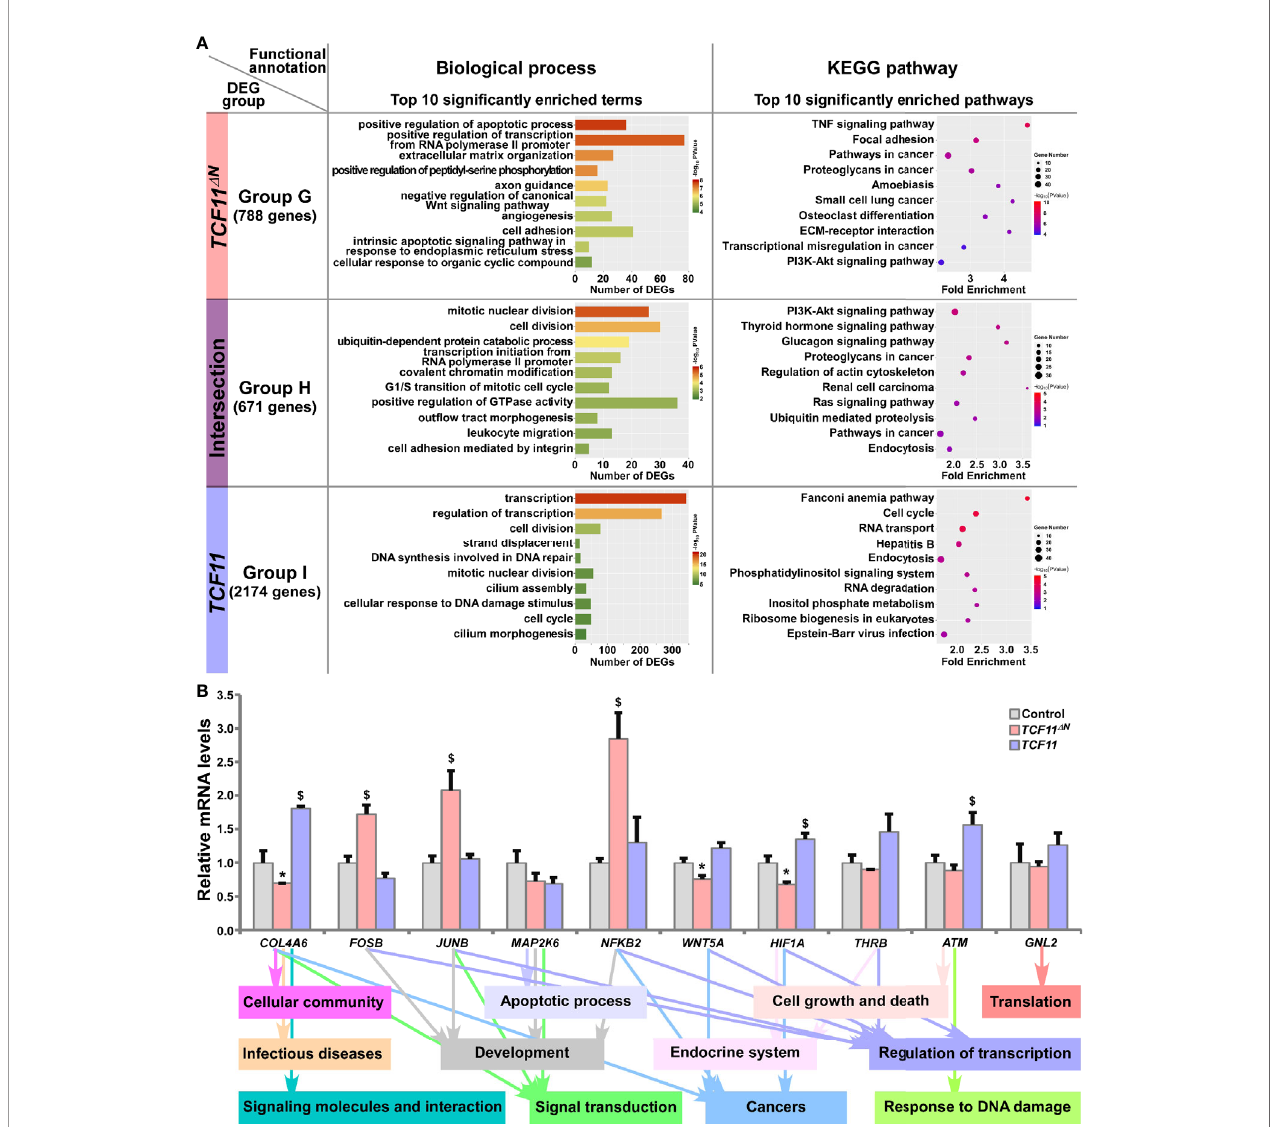
FIGURE 5 | Functional annotation of speci fi c or common DEGs in TCF11 D N and TCF11 cells. (A) Top 10 of signi fi cant biological process terms and pathways enriched by DEGs in Groups G, H, and I were exhibited in histograms and scatterplots, respectively. (B) After induced with 1 m g/ml Tet for 12 h, total RNAs were isolated from Control, TCF11 D N or TCF11 cell lines before being reversely transcribed into the fi rst strand of cDNA. Subsequently, relative mRNA levels of DEGs that were associated with more functions, along with high expression levels and well signi fi cance in Groups G to I, were determined by quantitative real-time PCR in Control, TCF11 D N and TCF11 cells. The data are shown as mean ± SEM (n = 3 × 3, * p < 0.05; $ p < 0.05, when compared to the Control values